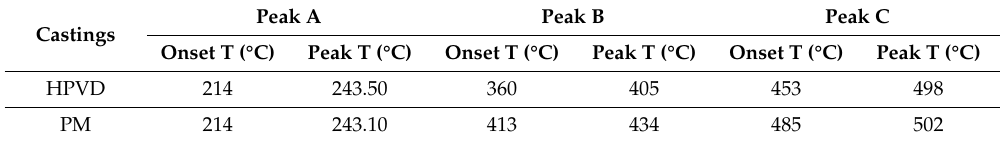
Figure 11. Typical differential scanning calorimetry (DSC) heating curves after solution treatment (500 °C for 3 h) of the HPVD ( a ) and PM ( b ) casting samples. Table 4. Average values of onset and peak temperatures of precipitation in HPVD and PM castings.